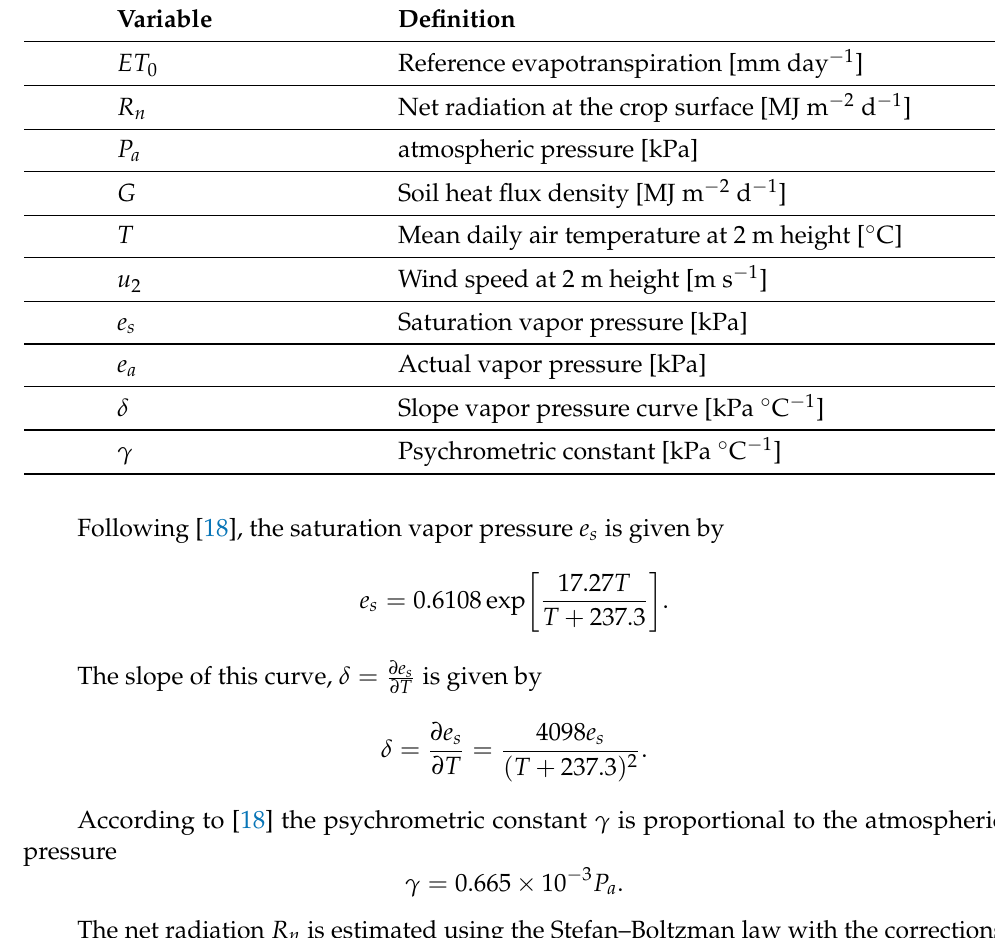
Table 1. Definitions of parameters in the Penman–Monteith equation. We used historical data to de- velop stochastic models for radiation, temperature, wind speed, and vapor pressure in the